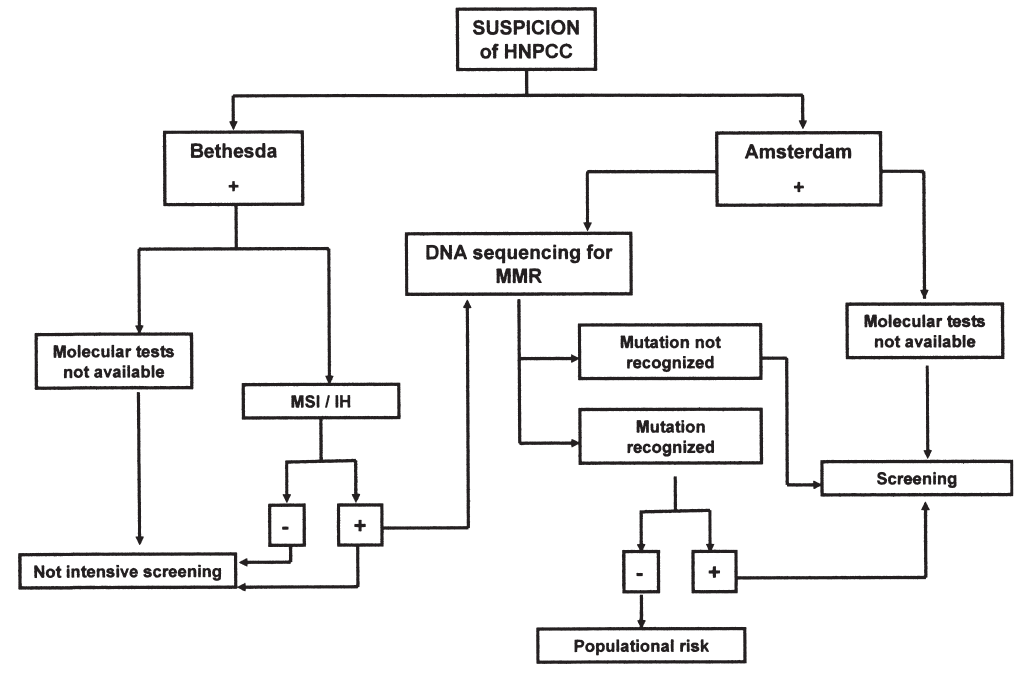
Figure 1 - Algorithm for Hereditary nonpolyposis colorectal cancer (HNPCC) diagnosis 20